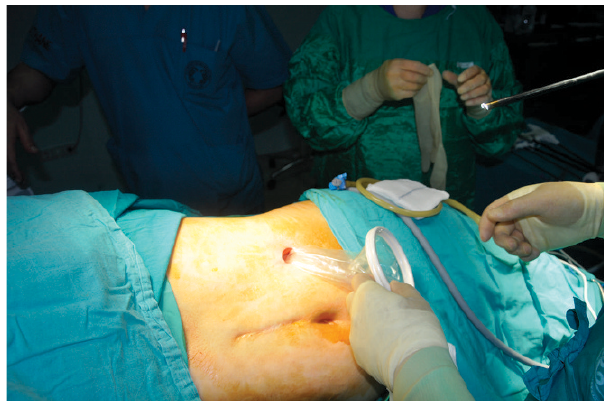
Figure 3 - Cutting the hilum of the spleen using an Endo-GIA II stapler.